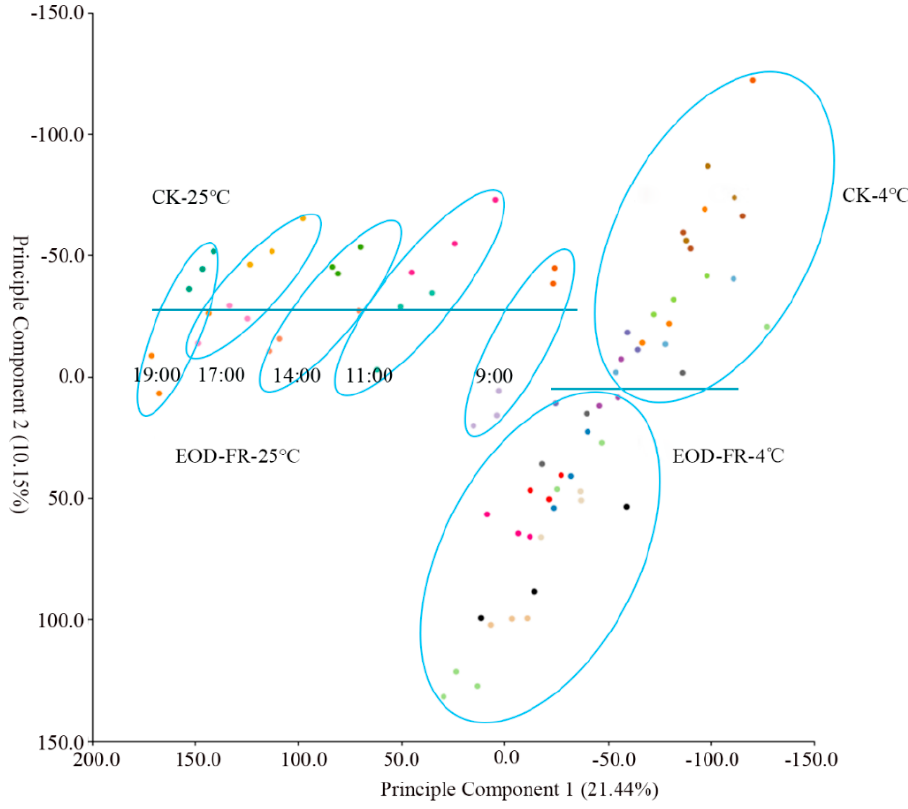
Figure 2. PCA of RNA-Seq data under EOD-FR and cold stress